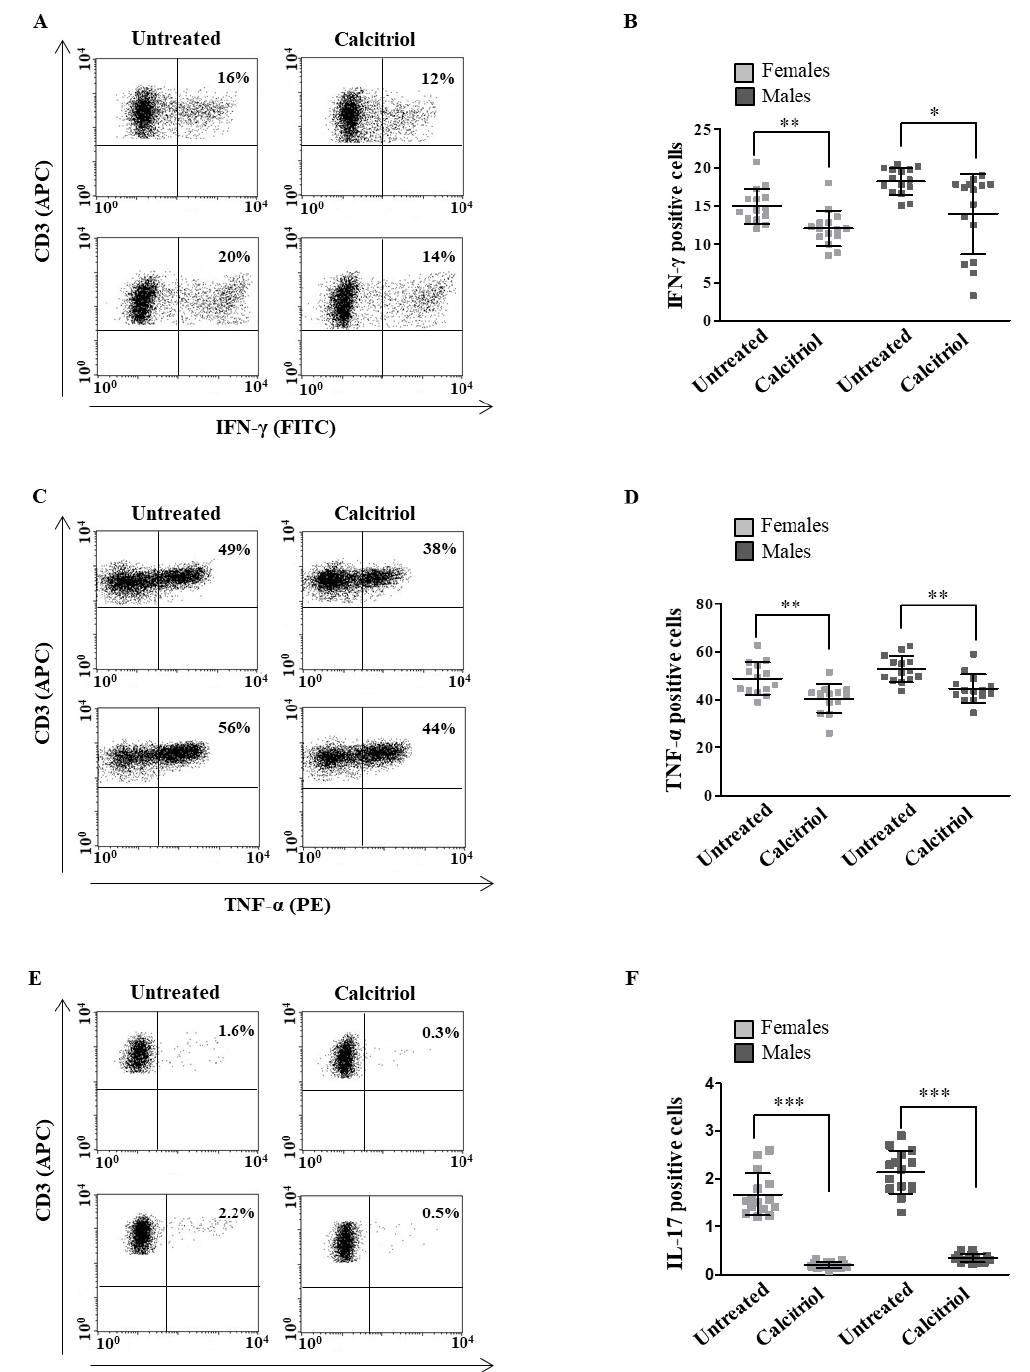
Figure 2. Calcitriol effects on pro-inflammatory cytokine production in peripheral blood T lymphocytes from female and male healthy donors. Cytokine expression was analyzed in 15 female and 15 male healthy subjects by flow cytometry after 48h of culture with calcitriol and stimulation with phorbol myristate acetate (PMA) and ionomycin in the presence of brefeldin A for the last 16h of culture, as detailed in Section 4. Results from representative female (upper panels) and male (lower panels) healthy donors are shown ( A , C , E ). Data are also reported as mean ± SD ( B , D , F ). * p < 0.05, ** p < 0.01, *** p < 0.001 versus untreated cells.